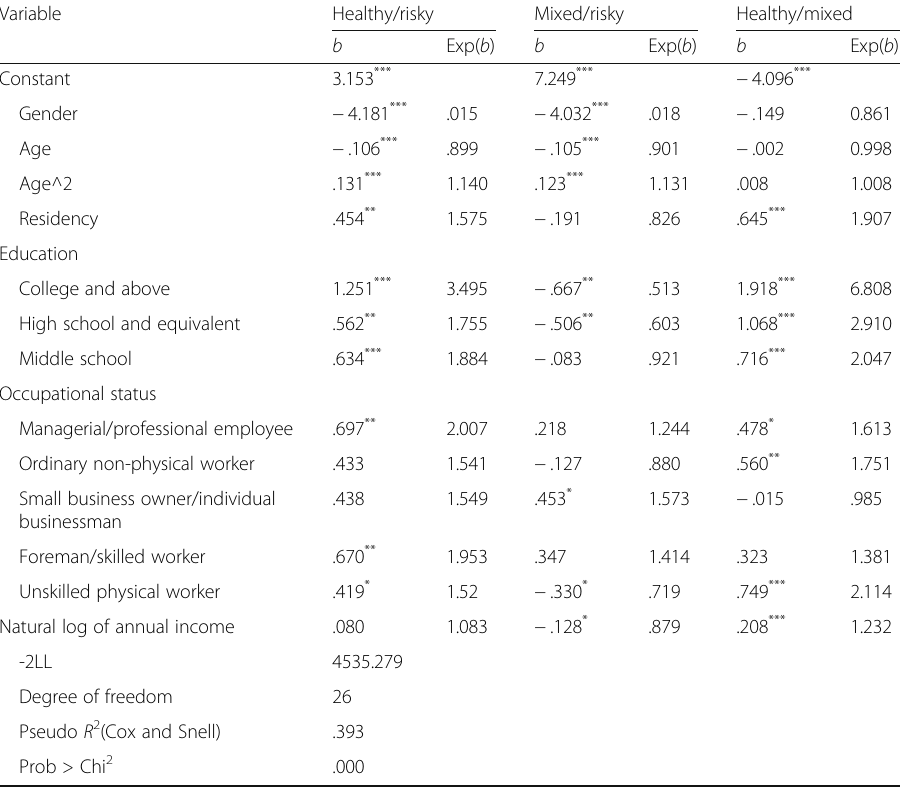
Table 4 Multivariate logistic regression of the SES-lifestyle relation Variable Healthy/risky